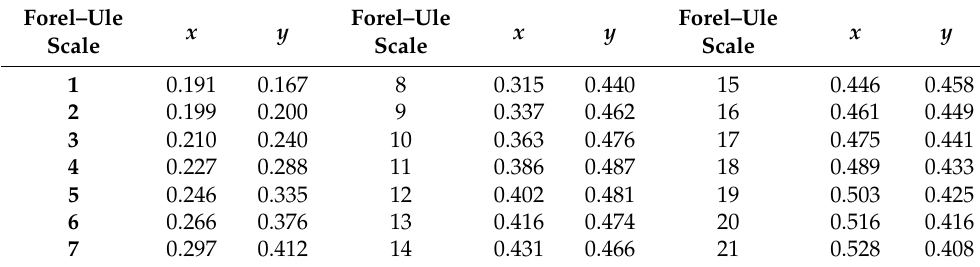
Table 2. Chromaticity coordinates ( x , y ) estimated by Novoa et al. [60] for each Forel–Ule water type. Forel–Ule Forel–Ule Forel–Ule x y x y Scale Scale